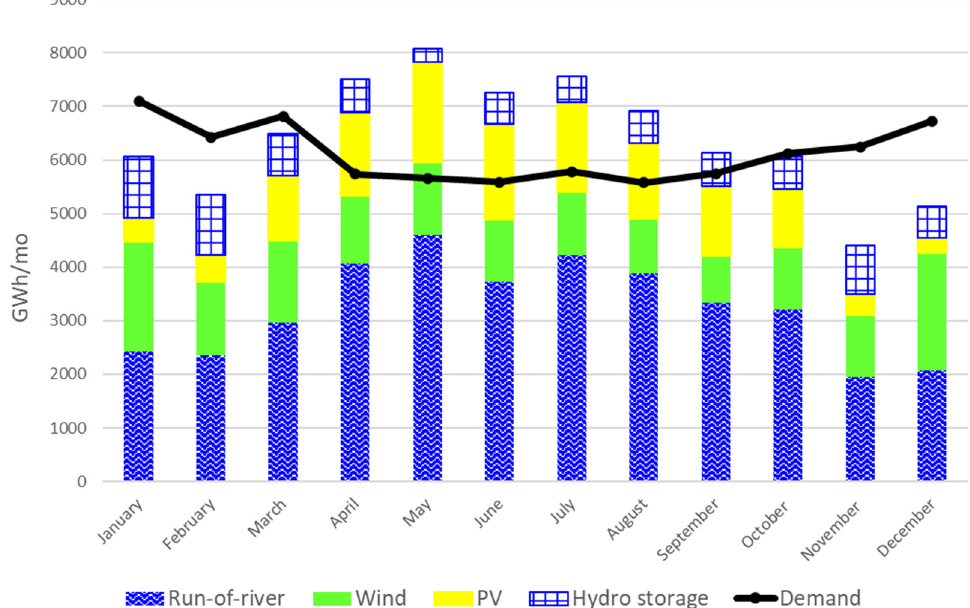
Fig. 5. Electricity generation and demand in Austria (w/o without pumped storage) in a BAU-Scenario on a monthly base with 100% RES in 2030 (balancing principle) in